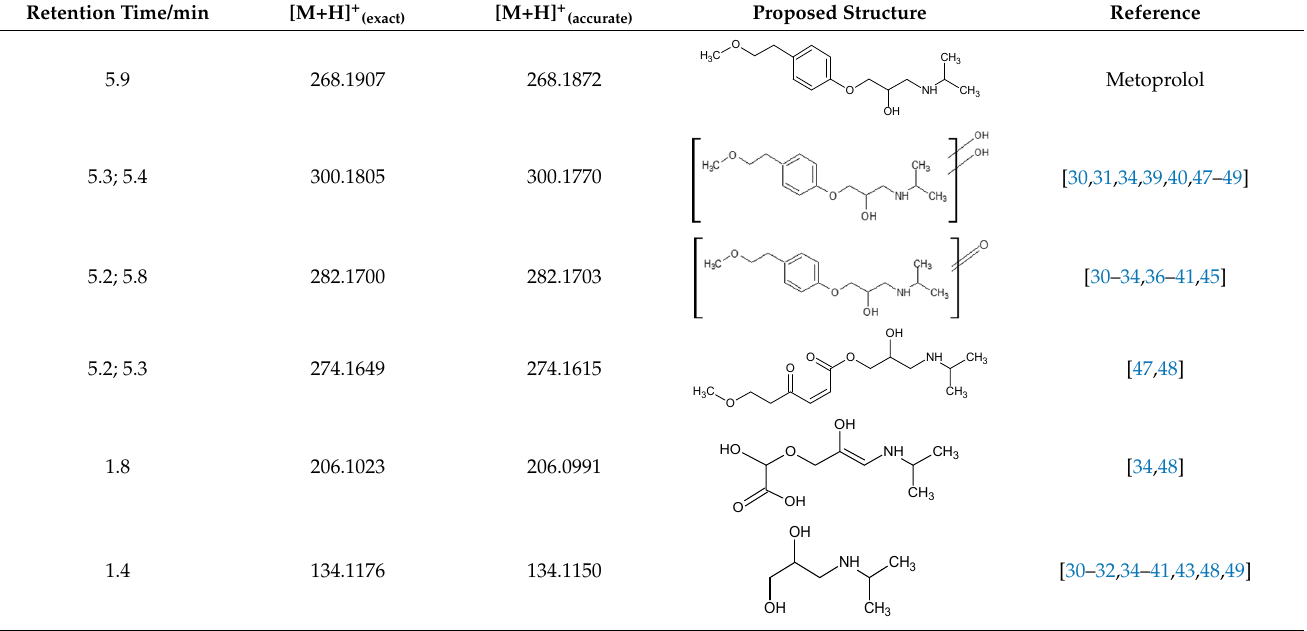
Figure 3. Normalized c-t -curves of ozonation of metoprolol using ozone-flow (red, ♦ ) and in ozone-saturated solution (green, ■ ). Table 3. Ozonation products of metoprolol: Retention times, exact and accurate mass, and structure proposal. Retention Time/min